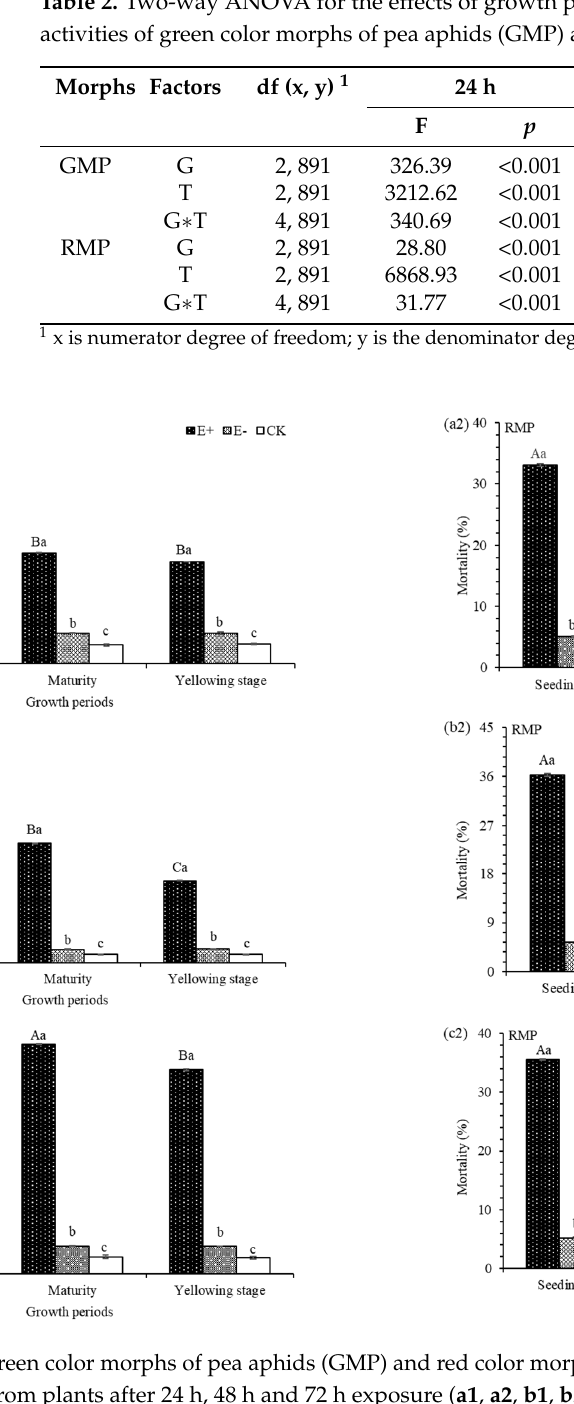
Table 2. Two-way ANOVA for the effects of growth periods (G) and treatments (T) on insecticidal